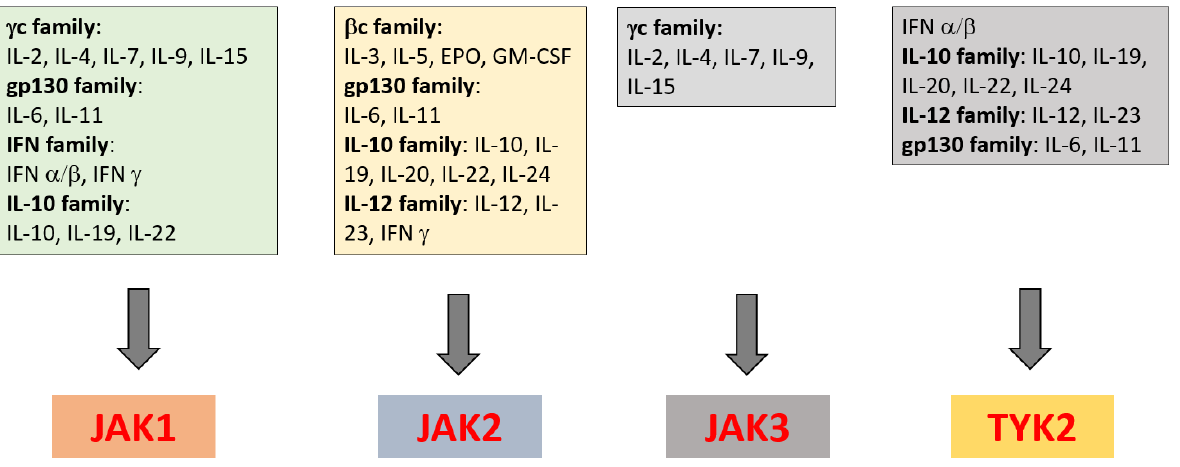
Figure 1. Use of the members of the Janus kinases (JAKs) (one or more JAK) by different cytokines. 4. The Implication of the JAK/STAT Pathway in Spondyloarthritis Different cytokines signal by using different pairs of JAKs. For instance, the γ -common cytokines (including IL-2, IL-4, IL-7, IL-15, and IL-21) signal by using JAK1/JAK2, inducing adaptive immune cell differentiation. IFN γ and IL-12 signal through JAK1/JAK2 and JAK2/TYK2, influencing Th1 response and production of TNF α (Figure 1) [20]. IL-23 signals via a JAK2/TYK2 combination, while IL-6 uses JAK1/JAK2 [10,22]. The IL-22 signal is mediated by JAK1/TYK2. IL-7 signaling uses JAK1/JAK3 and induces IL-17 production by mucosal associated invariant T (MAIT) cells [10]. Of interest, TNF α , a key cytokine driving inflammation in axSpA, does not use the JAK/STAT pathway. However, inhibition of JAK2/TYK2 or JAK1/JAK2 modulates its production by the inhibition of IL-12 and IFN γ production [23–25]. Genetic studies have identified polymorphisms in JAK2 and STAT3 as susceptibility factors for AS [26]. Polymorphisms in TYK2 can influence susceptibility to different autoimmune/inflammatory diseases, including AS [27]. Furthermore, JAK2 polymorphisms have been described in immune-mediated diseases that are associated with axSpA, namely Crohn’s disease or psoriasis [28]. Collectively, polymporphisms in JAK/STAT argue for a role of this kinase system in the pathogenesis of axSpA. Finally, experimental models of SpA provide additional mechanisms implicating the JAK/SAT pathway in axSpA. Indeed, blockade of JAK/STAT in animal models results in clinical changes in SpA: in an SKG mouse model of SpA induced by curdlan, blockade of JAK/STAT suppressed inflammation and periosteal/entheseal bone formation [29]. JAKi may reduce Th17 response in CD4+ T cells from patients with AS [30]. In the SKG model of SpA, a TYK2 inhibitor was capable of blocking disease progression [31]. In addition, this JAKi may abrogate IL-22 production and partially inhibited IL-17 production by γδ T cells. In the A20 (TNF α induced protein-3)-deficient mouse model, which involves the synovio–entheseal complex, tofacitinib, a pan-JAK inhibitor, significantly reduced enthesitis. Importantly, inflammation in this model is independent of TNF α [32]. Collectively, these experimental data strongly support the involvement of the JAK/STAT pathway in axSpA and also indicate that the best targets among the different JAKs are certainly TYK2, JAK2, and JAK1